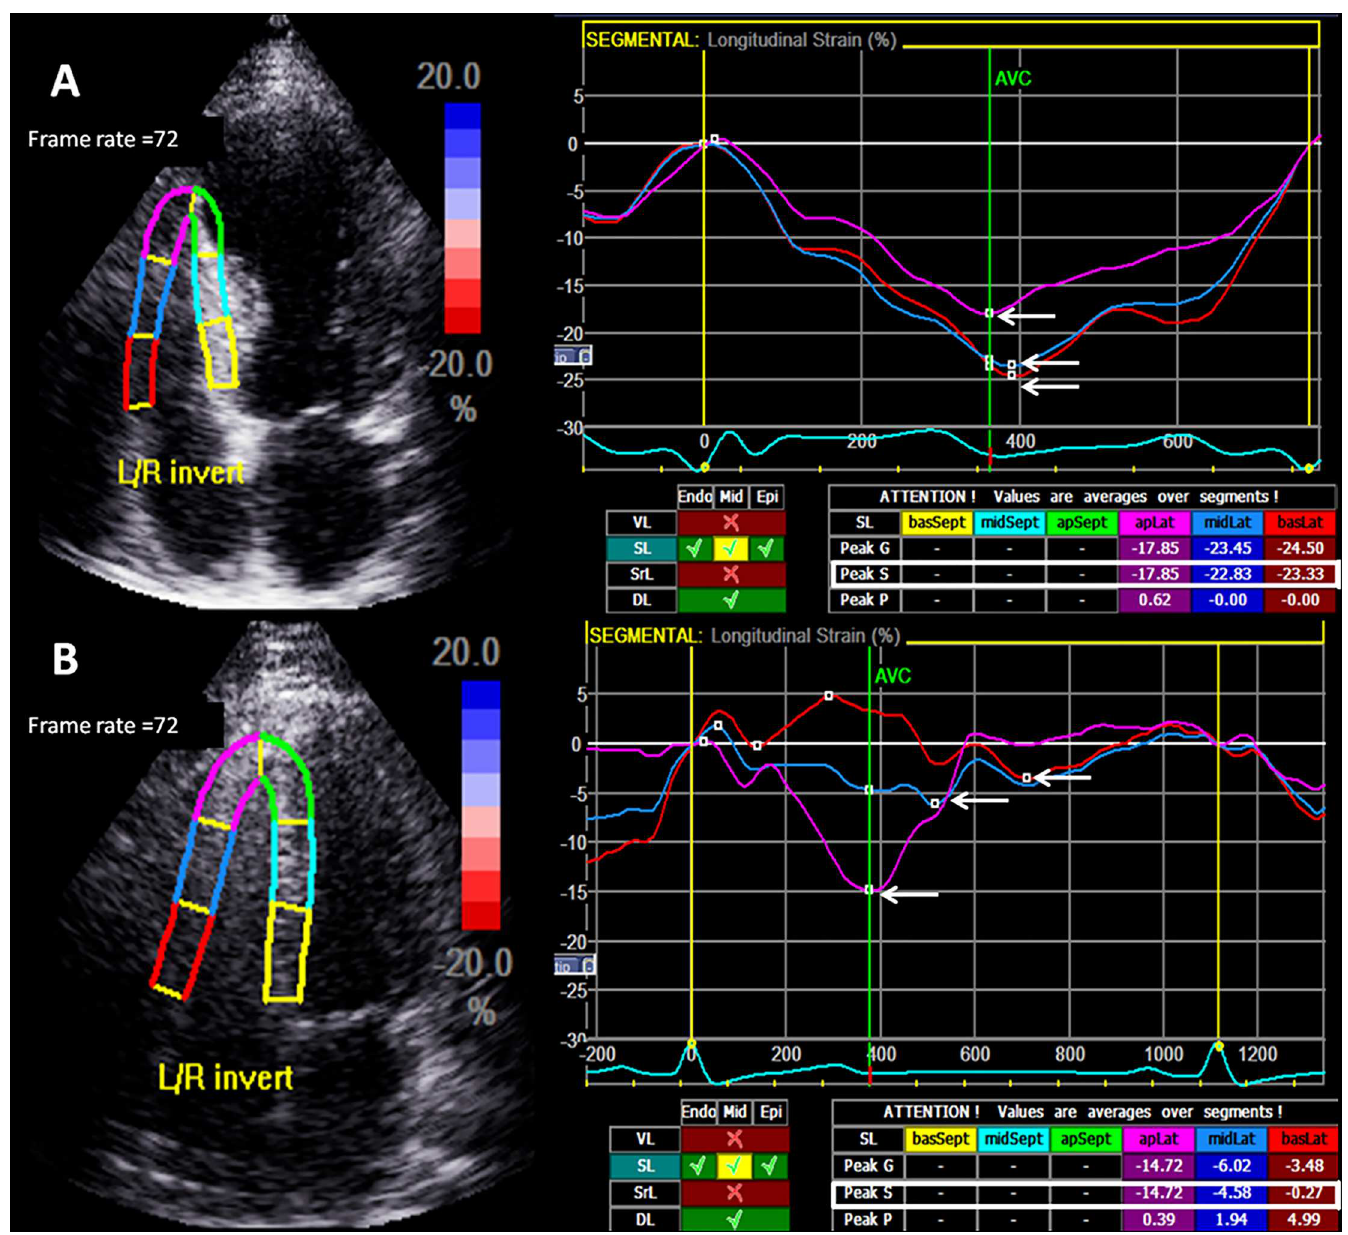
Fig 1. An example of measurement of right ventricular strain at free wall in a function preservedright ventricle (above) and the other function impaired right ventricle